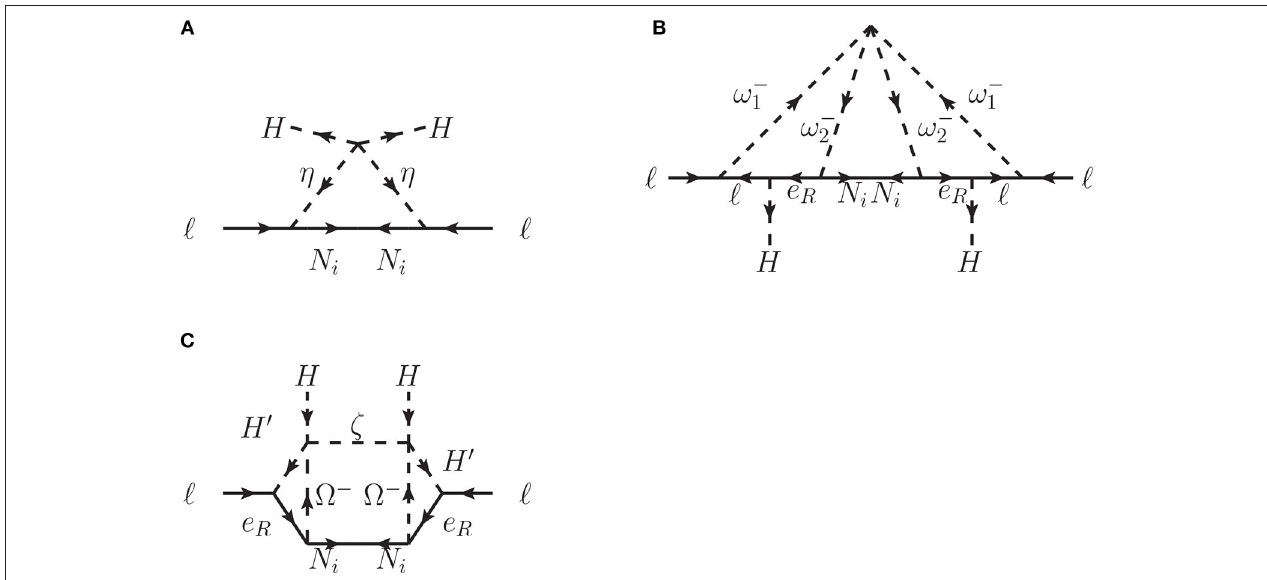
FIGURE 1 | Relevant diagrams for neutrino mass in (A) the Ma model [29], (B) the KNT model [28], and (C) the AKS model [32–34].